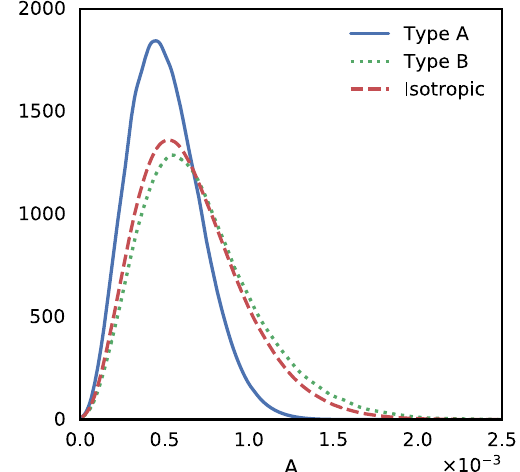
unchanged, thensubstitutedistancemoduli as typeA data sets.